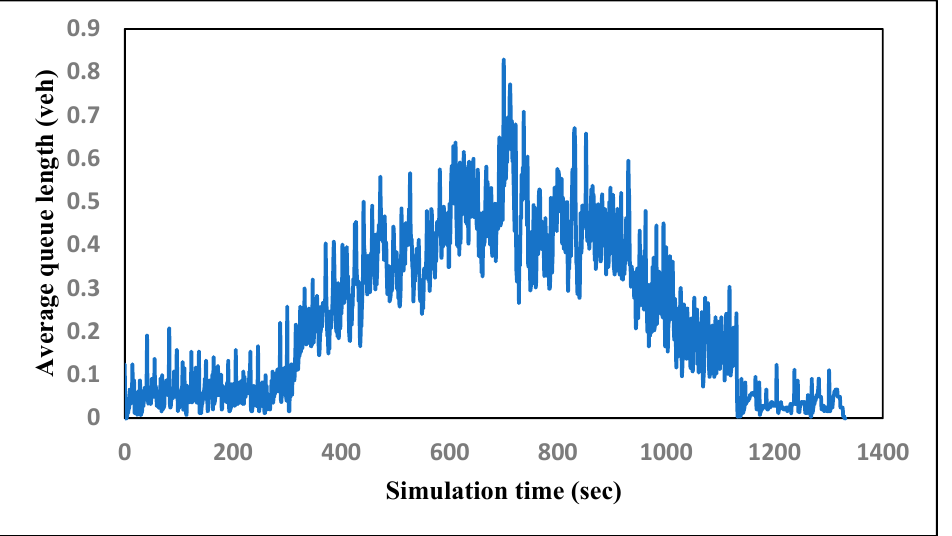
Figure 8. Average queue length in synthetic traffic grid.